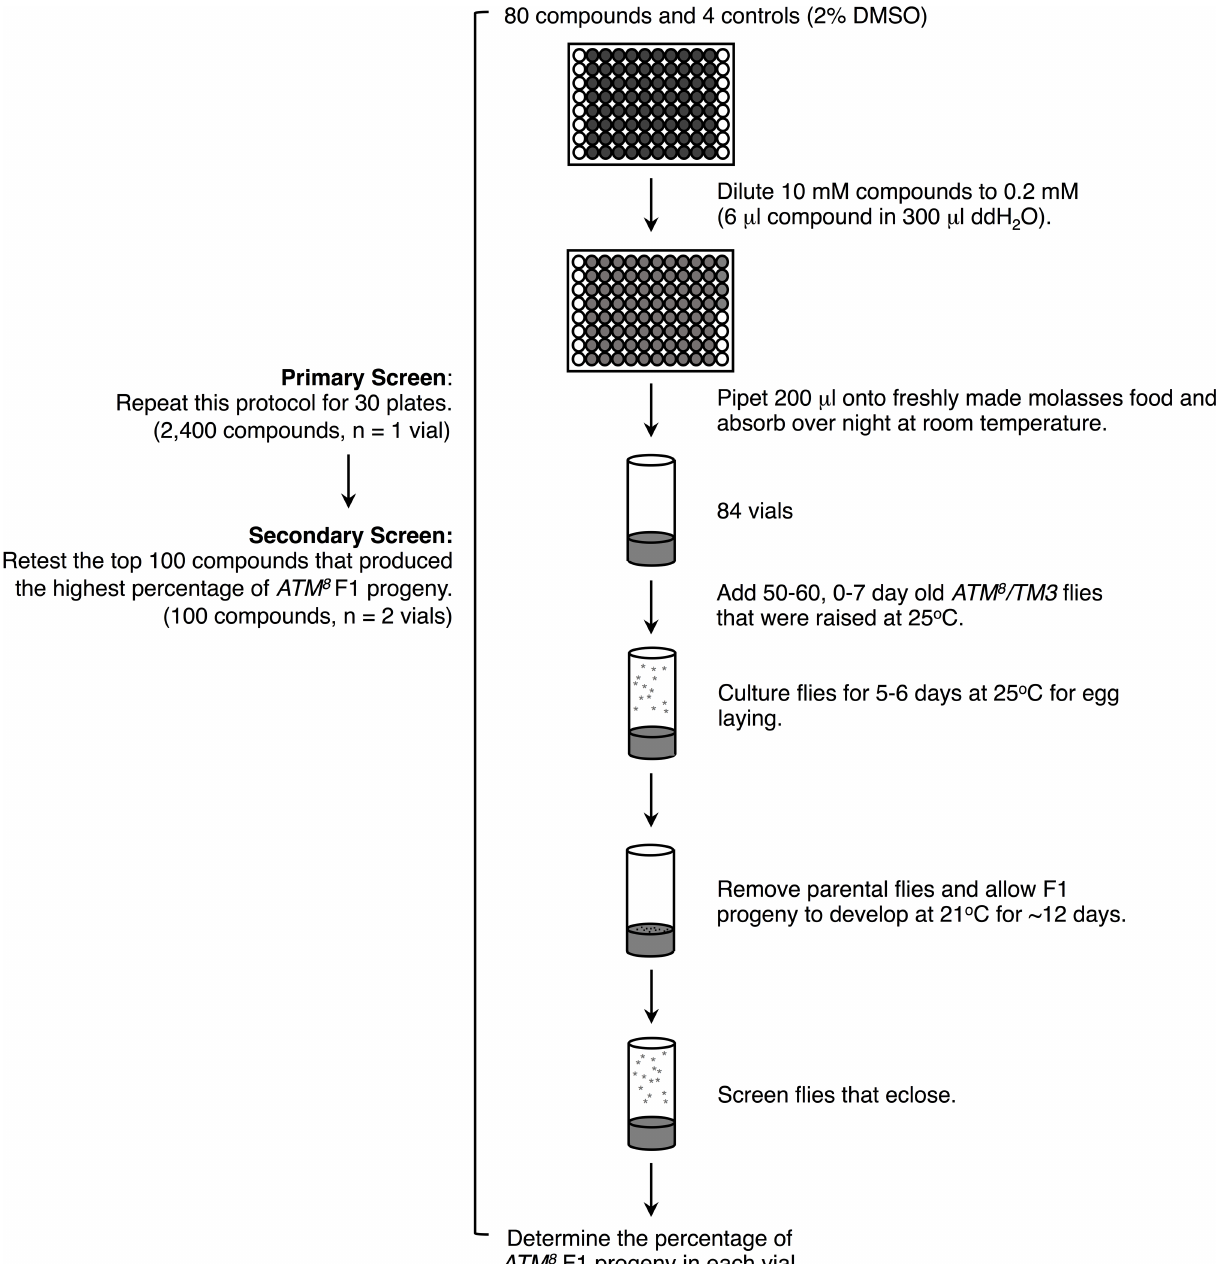
Fig 1. Schematic diagram of the primary and secondary screen protocols. Detailsare provided in the Materialsand methods section as well as the Results and discussion section.